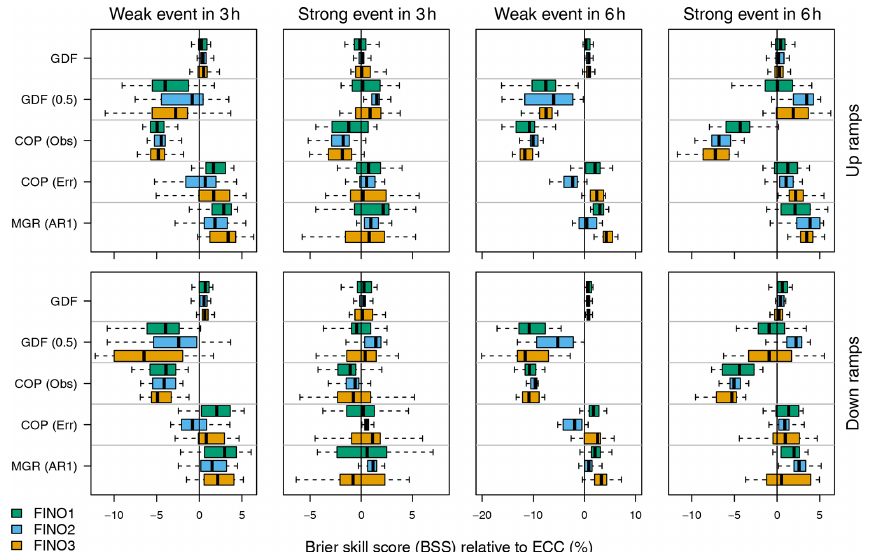
Figure 6. As in Fig. 5 but for the Brier skill score